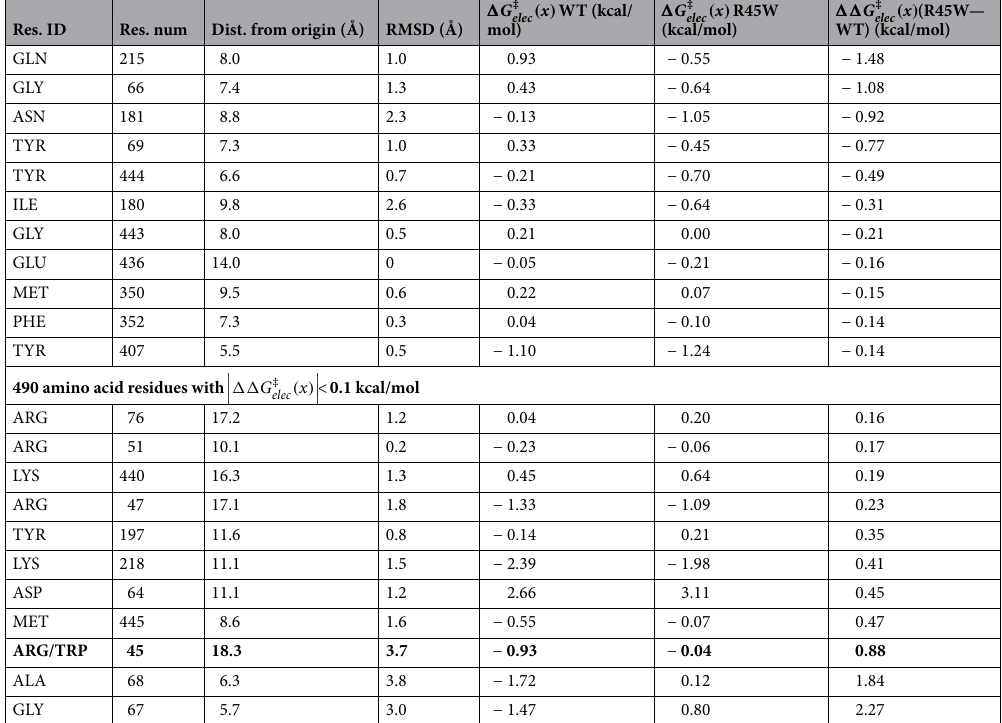
Table 3. Residues with biggest difference (between WT and R45W) in contribution to the barrier lowering effect due to the interaction between the electric field and the dipole moment. The residues that have a larger catalytic effect in R45W are listed in the top half of the table (negative difference in � G residues that have a larger catalytic effect in WT are listed in the bottom half of the table (positive difference in � G ‡ elec ( x ) ). Note that the total catalytic effect in R45W is by 3.1 kcal/mol smaller than in WT MAO-A. Average distance of residue from the midpoint between C of SRO and N of LFN is also given, as well as the RMSD between the average structures of WT and R45W. The mutated residue is marked in bold.